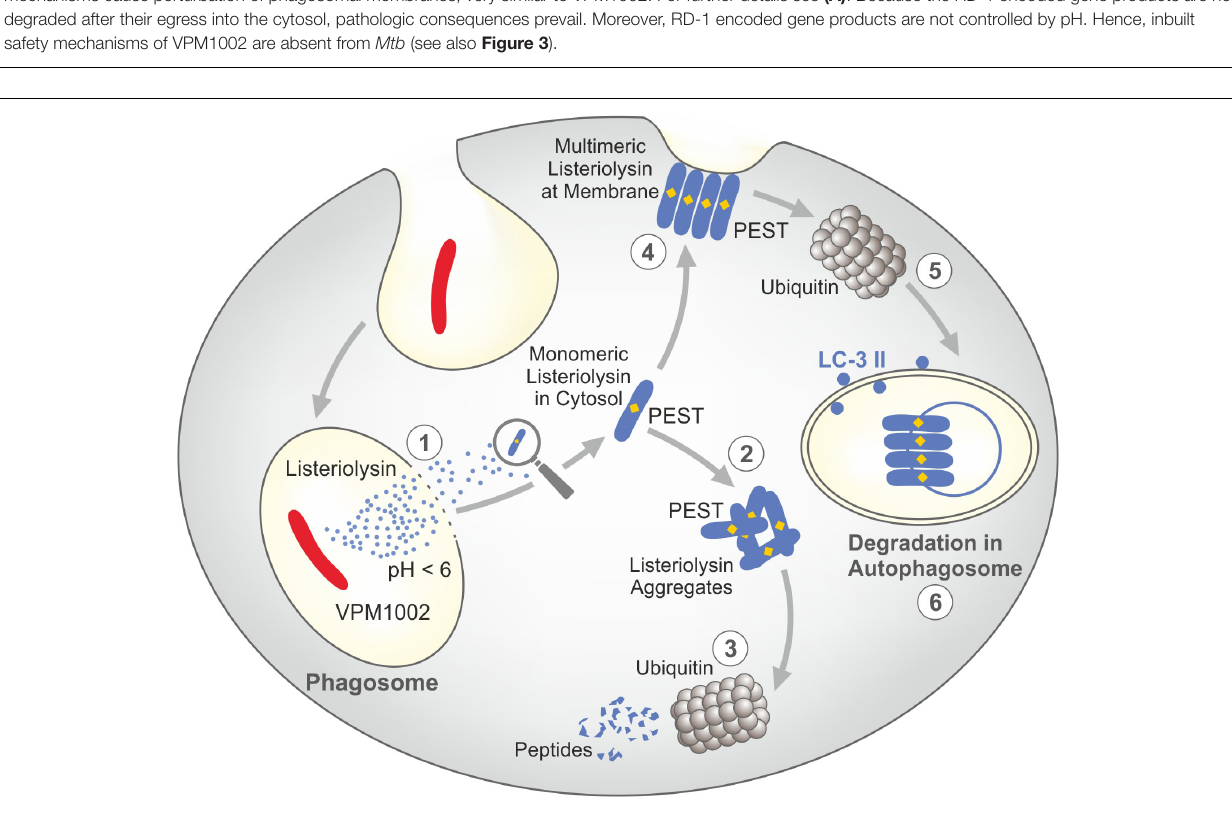
FIGURE 3 | Safety mechanisms of listeriolysin render VPM1002 less virulent than parental BCG. Listeriolysin contains a PEST-like sequence which promotes its degradation. (1) Only at acidic pH, listeriolysin is biologically active and hence perturbates the phagosomal membrane. (2) In the cytosol, monomeric listeriolysin aggregates. (3) Aggregated listeriolysin is degraded by ubiquitin resulting in inactive peptides. (4) Multimeric listeriolysin complexes are formed at the plasma membrane. (5) These complexes are translocated into autophagosomes by ubiquitin. (6) These listeriolysin complexes are inactivated in the phagosome. PEST = Proline (P), Gutalate (E), Serine (S), and Threonine (T). Modified from